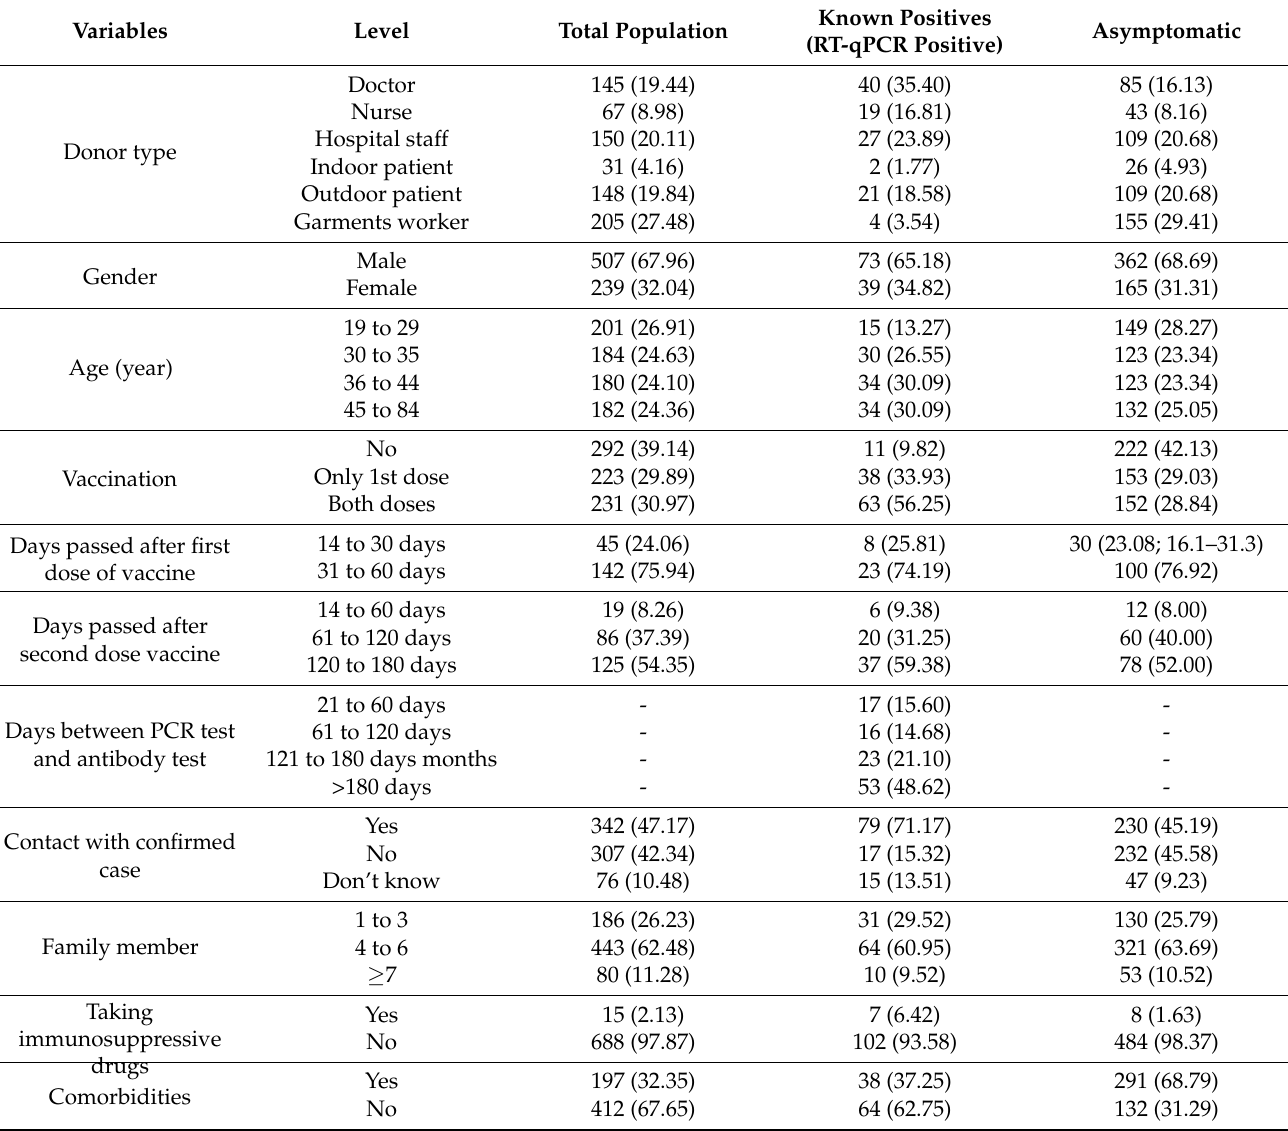
Table 2. Baseline characteristics of the study